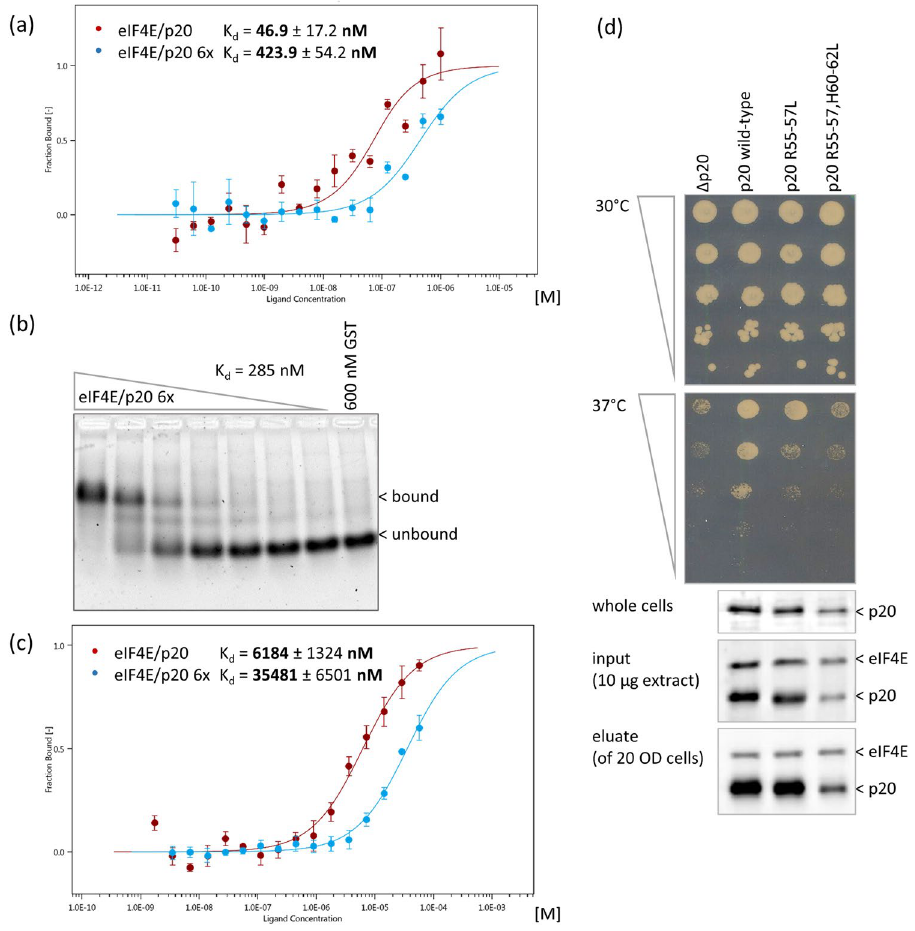
Supplemental Fig. S3. Blots were stained with polyclonal antibodies against eIF4E or p20 as